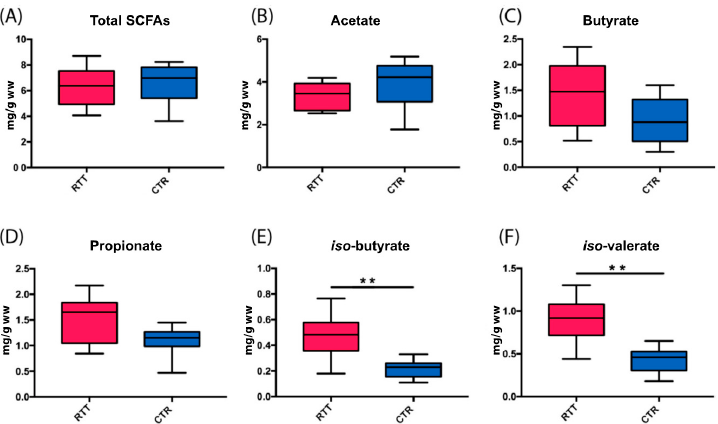
Figure 4. Box-and-whisker plots of fecal microbial metabolites in feces of Rett (RTT, magenta) and control (CTR, blue) subjects: ( A – D ) short-chain fatty acids (SCFAs); ( E , F ) branched-chain fatty acids (BCFAs). Data refer to mg/g wet weight (mg/g ww) of feces. Significant differences are indicated by ** ( p < 0.01), Mann–Whitney test.